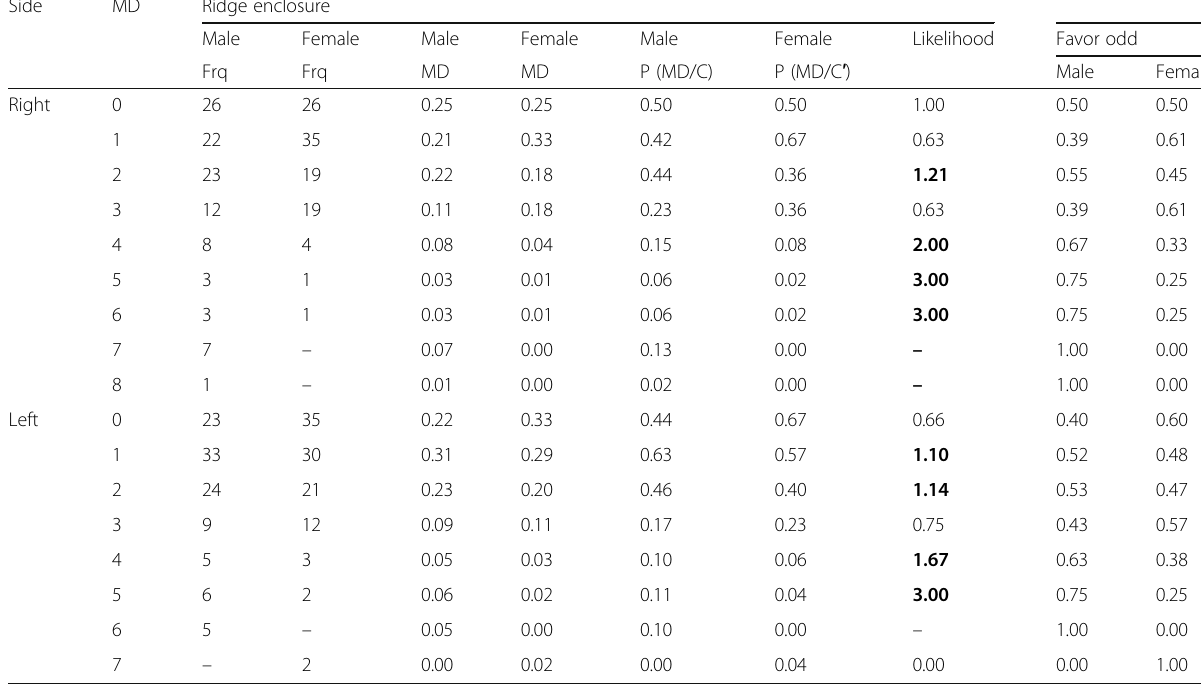
Table 3 Frequency, likelihood ratio and favor odd of different ridge enclosure density of right and left thumbprints Side MD Ridge enclosure Male Female Male Female Male Female Likelihood Favor odd Frq Frq MD MD P (MD/C) P (MD/C ′ ) Male Female Right 0